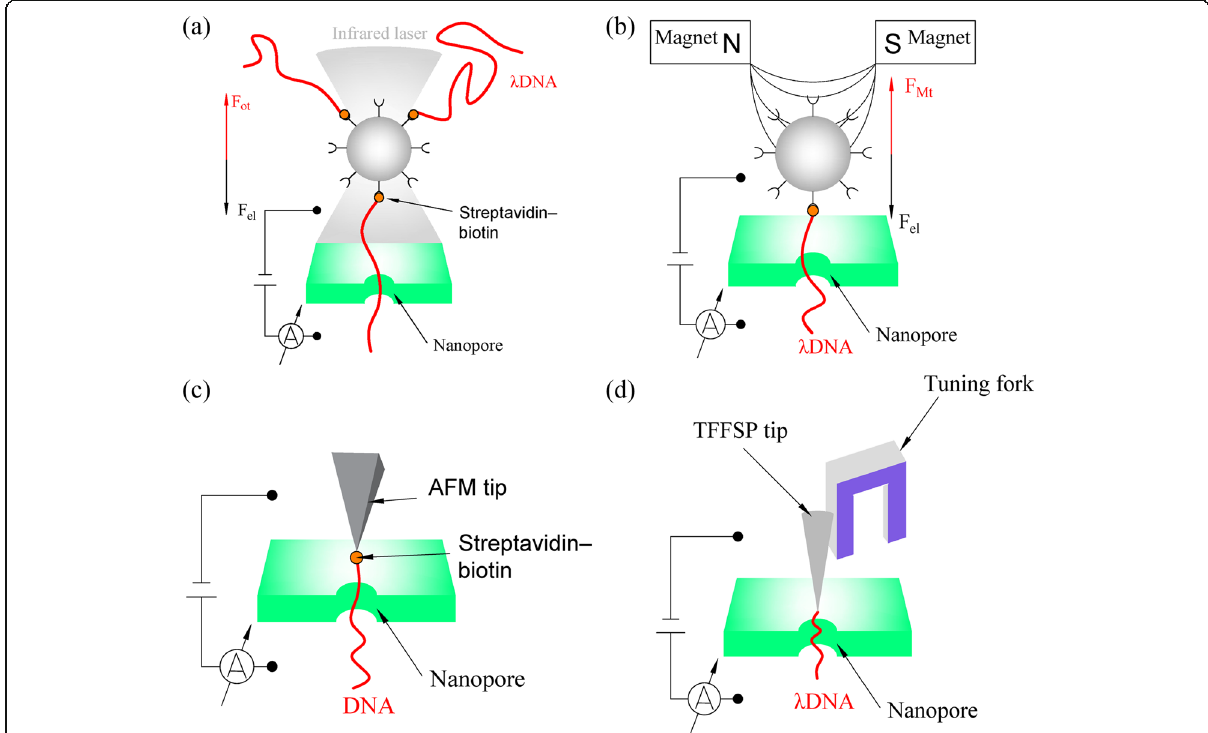
Fig. 4 a Schematic of optical tweezers used for nanopore DNA detection [48]. When the optical tweezers system is in equilibrium, the optical force (F ot ) is equal to the electric field force (F el ). b Schematic of magnetic tweezers used for nanopore DNA detection [49]. When the magnetic tweezers system is in equilibrium, the magnetic force (F Mt ) is equal to the electric field force (F el ). c Schematic of AFM used for nanopore DNA detection [50]. d Schematic of TFFS used for nanopore DNA detection